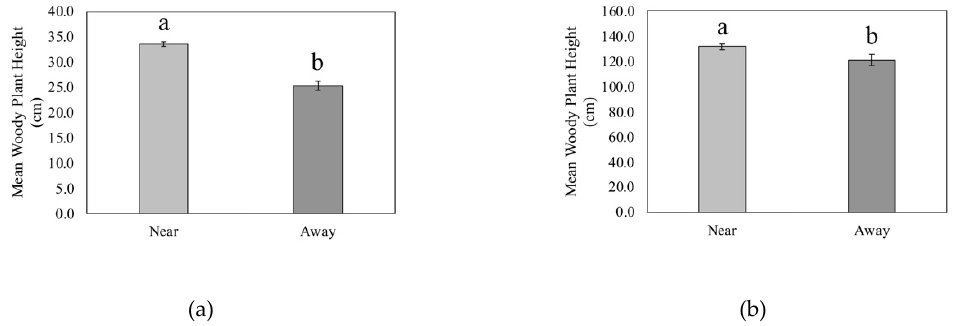
Figure 5 . Mean height of ( a ) seedlings (live woody stems <1 m height) and ( b ) saplings (live woody stems ≥ 1 m height, <5 cm dbh) of quadrats located near and away from coarse woody debris (CWD) in a Pinus palustris woodland following catastrophic disturbance. Different letters indicate significant differences at p < 0.05.